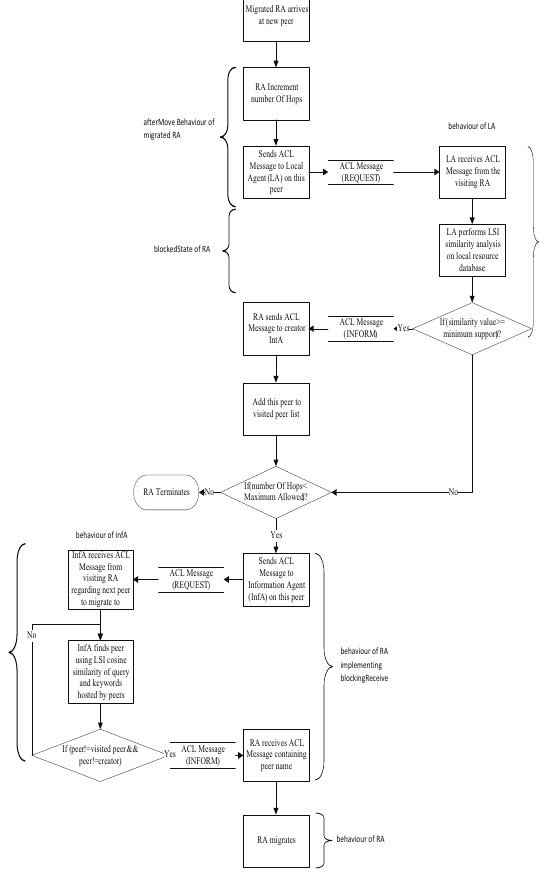
Fig. 5. Flow diagram for behaviour of the InfA and the LA upon arrival of the